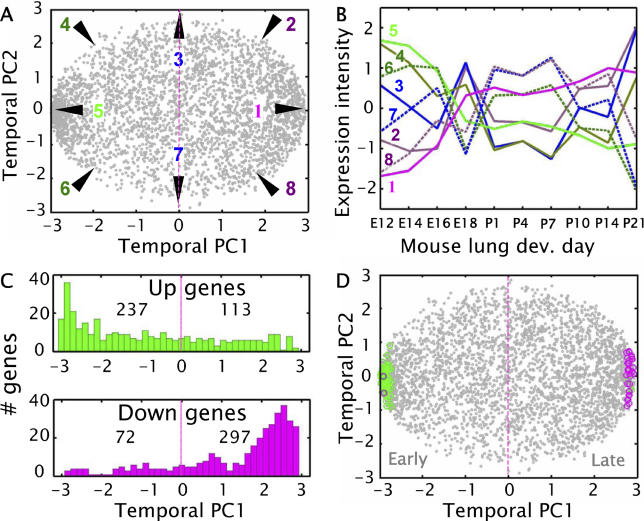
Mouse Lung Development Profiles in Temporal PC Representation, and the General Developmental Profile Segregation of Up- and Down-Regulated Genes in Human Lung Cancer(A) Expression profiles of all 3,590 unique genes during mouse lung development as represented in temporal PC1 and PC2. Each dot marks a gene.(B) Developmental profile examples of genes at the periphery of the disc-like scatter plot in (A) at 45° (π/4 radians starting at “3 o'clock”) rotational intervals.(C) Histograms of the mouse lung temporal PC1 coordinates of the 719 genes 2-fold significantly up- and down-regulated in any one of the four human lung cancer subtypes (χ
2 = 168.338,
p < 0.001, OR = 8.652).
(D) The profiles of the top 100 genes (68 cancer up-regulated [green circles] and 32 cancer down-regulated [magenta circles]) composing the malignancy signature (see
Results) among all 3,590 mouse lung developmental gene profiles. Of the 68 cancer up-regulated genes, all but two are in the late developmental profile hemisphere. Of the 32 cancer down-regulated genes, all but two are in the early developmental profile hemisphere (χ
2 = 82.5185,
p < 0.001, OR = 544).